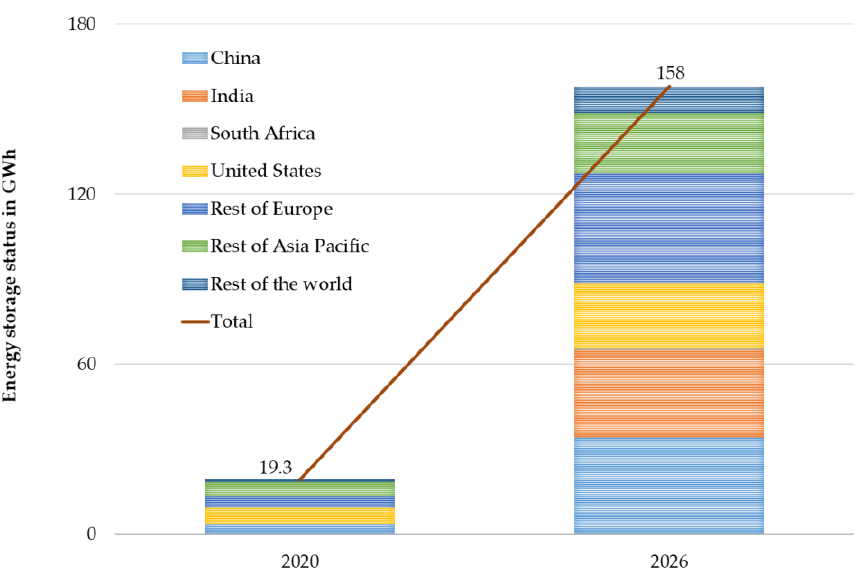
Figure 4 . Battery storage capability by countries, 2020 and 2026 [65]. Figure 4. Battery storage capability by countries, 2020 and 2026